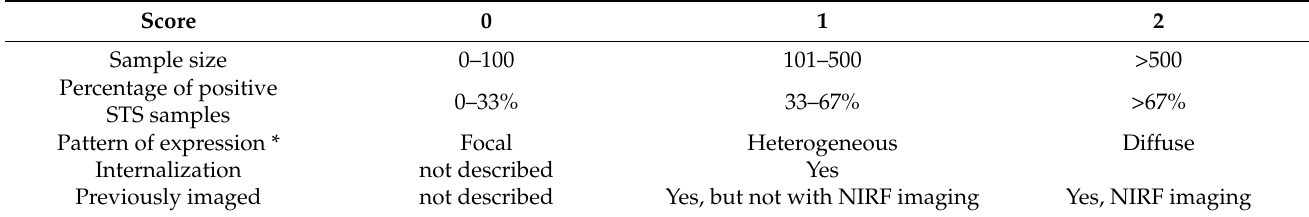
Table 1. Target selection scoring system.